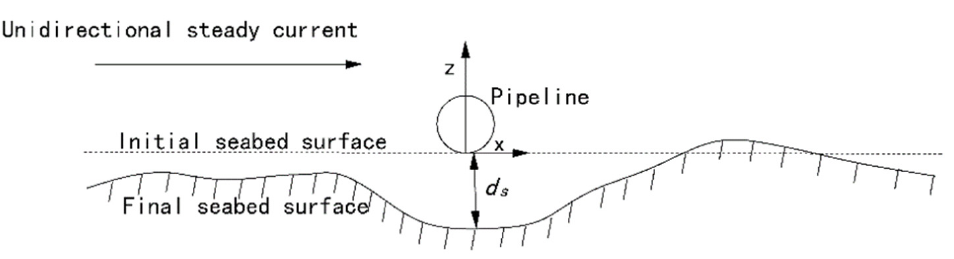
Figure 1. Live-bed scour profile around a submarine pipeline.